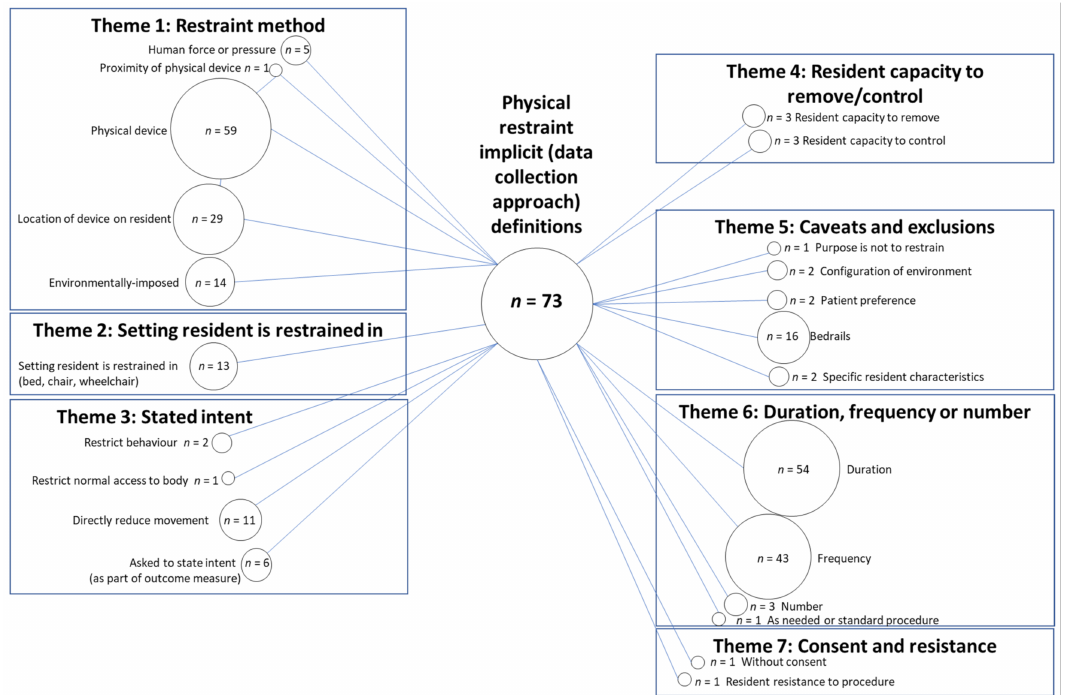
Figure 3. Codes and themes present within implicit definitions, based on data collection approaches of physical restraint. n = number of measurement approaches for which this code was